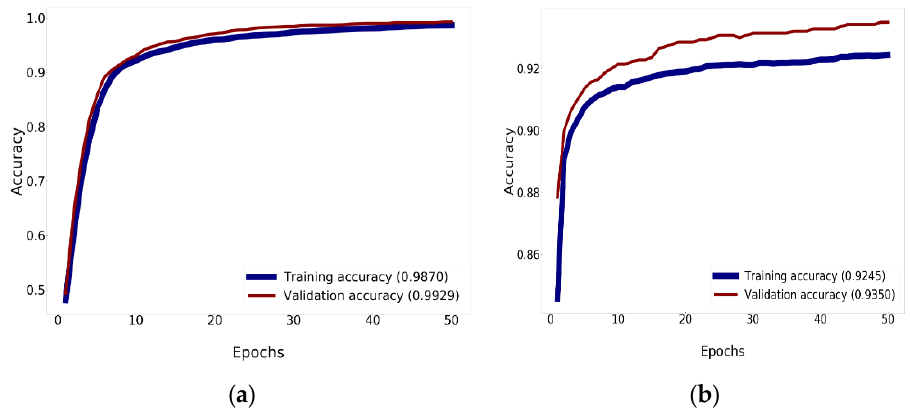
Figure 11. The accuracy history of validation and training: ( a ) Accuracy of training and validation of Xception using Nadam and Mish; ( b ) the accuracy of training and validation of Xception.